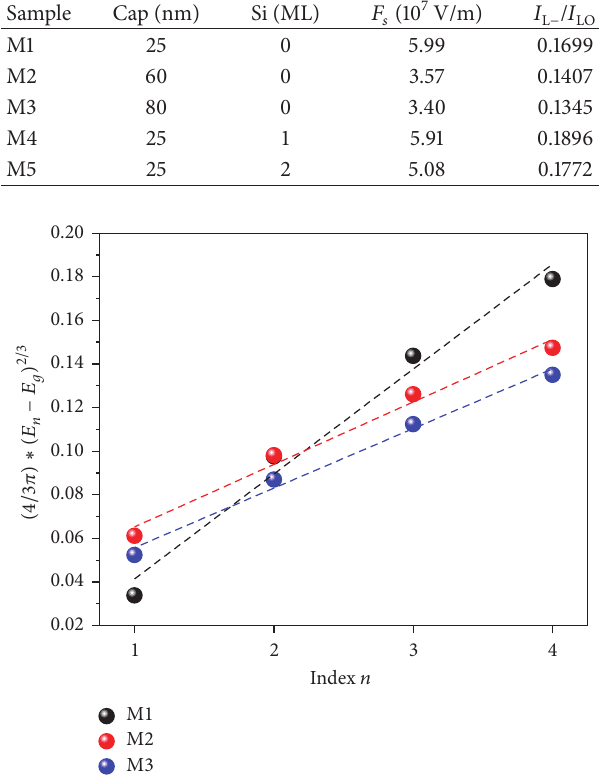
Figure 4: Linear fit in w-FKO analysis from PR spectra of M1, M2, and M3.